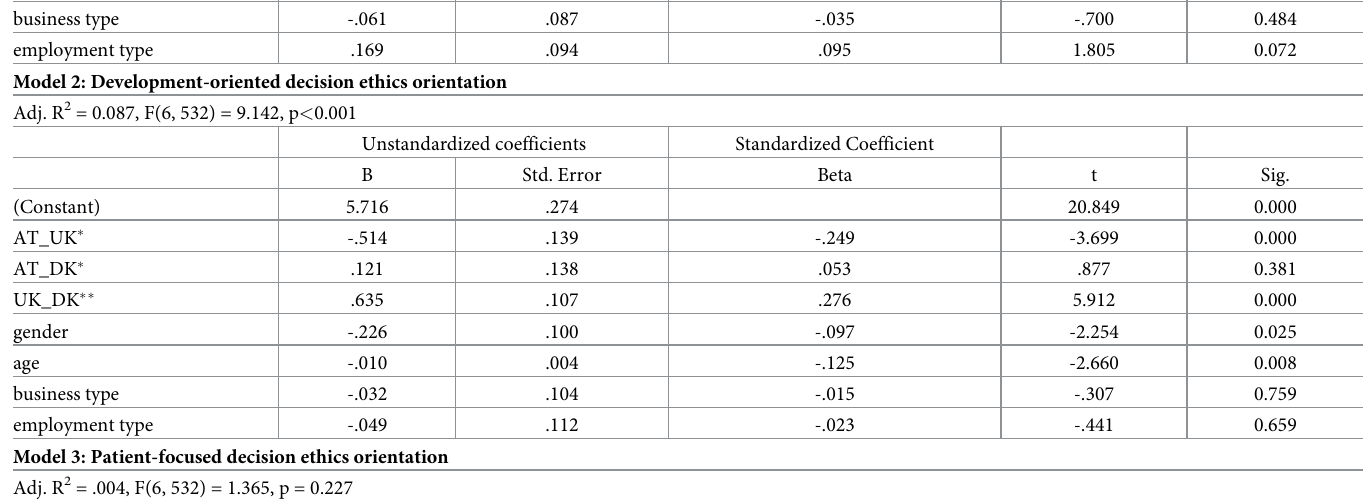
Model 3: Patient-focused decision ethics orientation